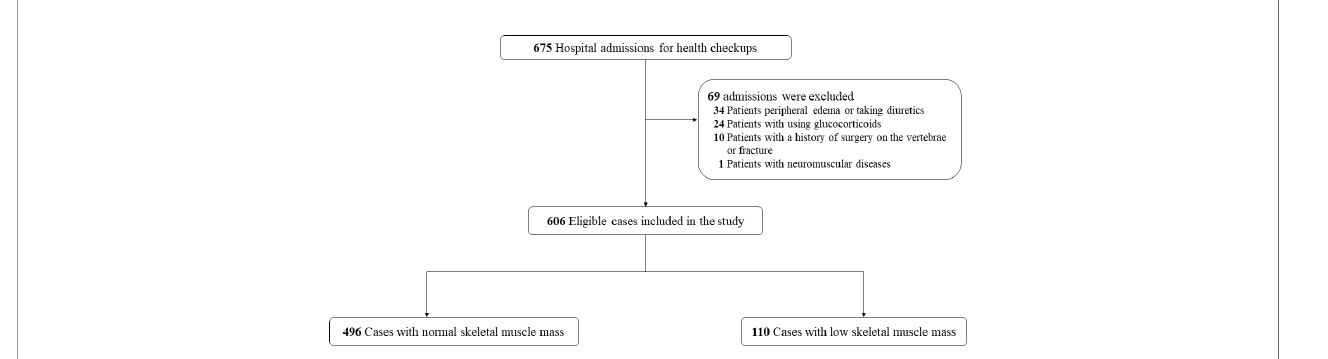
FIGURE 1 | Flowchart of the